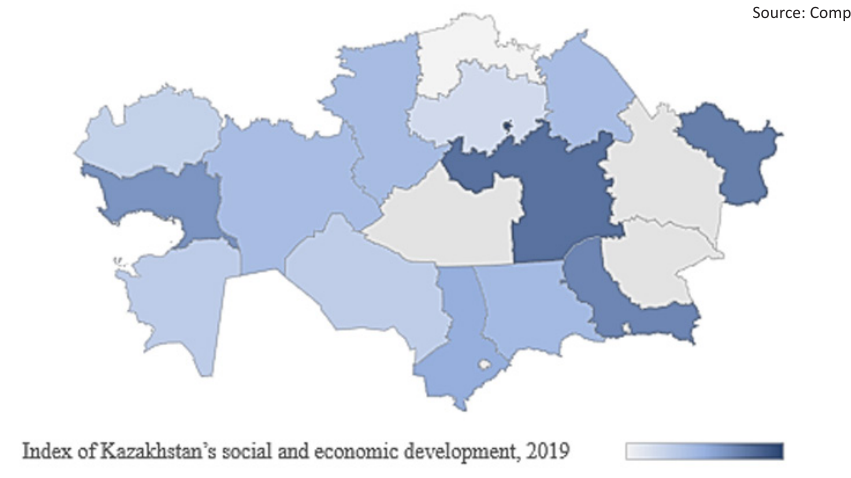
Figure 2. Socio-economic inequality in Kazakhstan ,